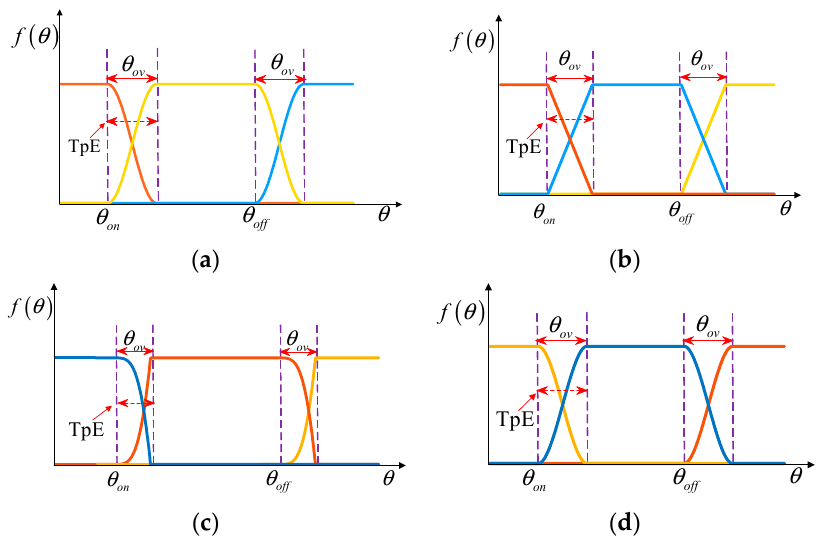
Figure 4. Four conventional TSF waveforms in TpE: ( a ) cosine; ( b ) linearity; ( c ) exponent; ( d ) cube.